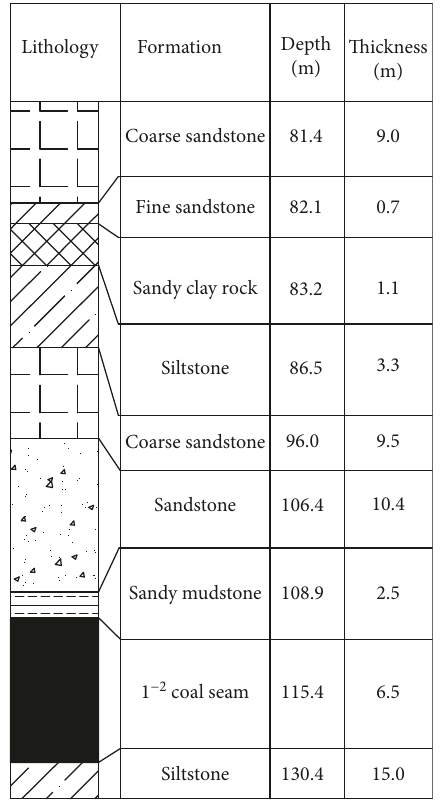
Figure 2: The roof and fl oor lithology closed to no. 1 − 2 coal